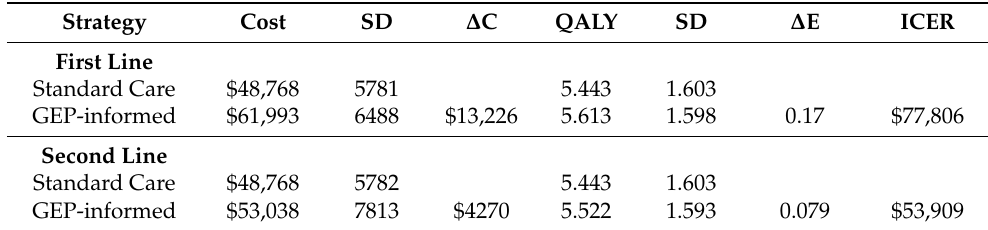
Table 3. Cost effectiveness results at varying assumptions of reductions in disease recurrence, baseline